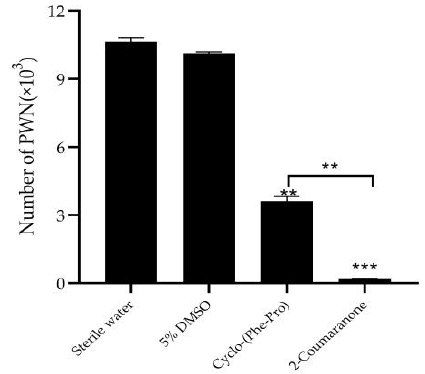
Figure 7. Numbers of PWN per dish treated with 2-coumaranone, cyclo-(Phe-Pro), 5% DMSO, and sterile water. Mean values of four replications were plotted with SD. ** and *** represent significant difference at p < 0.01 and p < 0.001 , respectively, compared to control according to Student’s t -test.